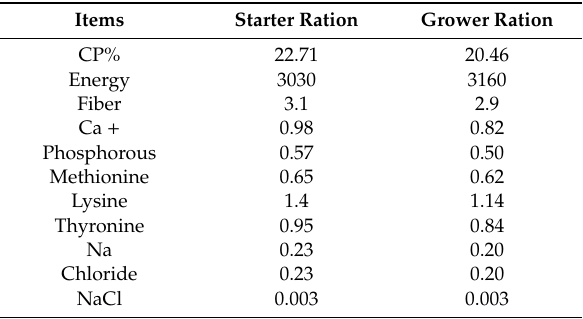
Table 1. Experimental ration composition and ingredients.